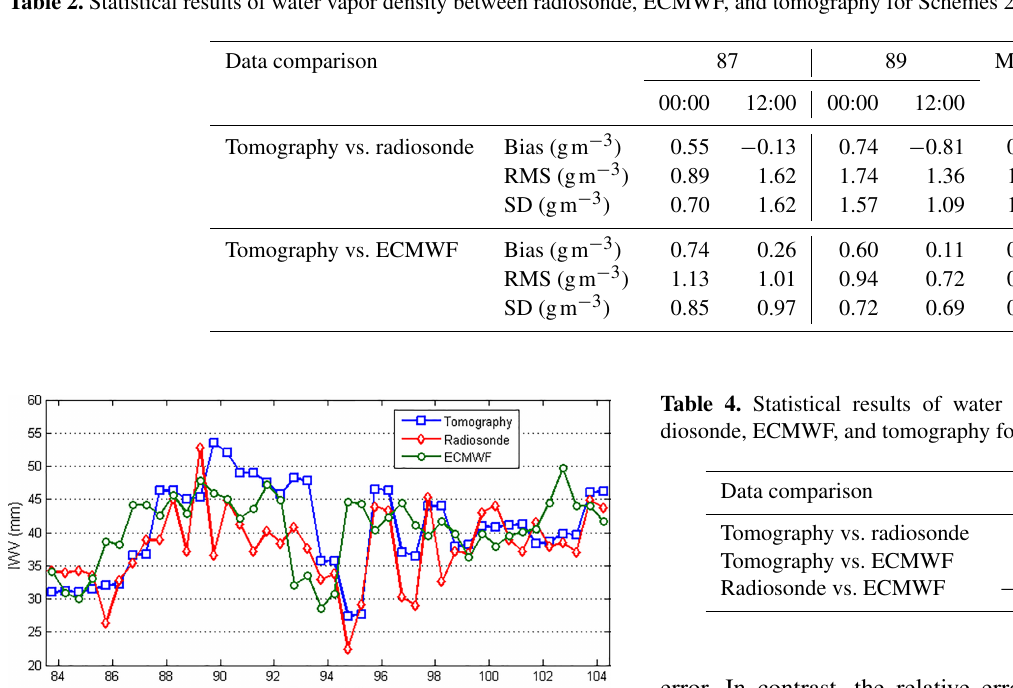
Table 2. Statistical results of water vapor density between radiosonde, ECMWF, and tomography for Schemes 2 and 3 (unit: gm − 3 ).